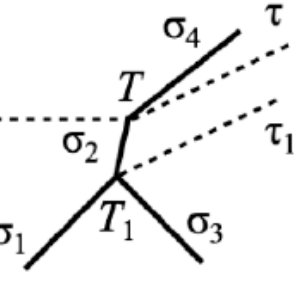
Figure 10. Shock wave configuration for Mach refraction. For irregular refraction, the incident shock σ 1 branches with the formation of a re- flected shock σ 3 and a main shock σ 2 (the Mach stem). The main shock experiences characteristic refraction on the tangential discontinuity τ . The Mach stem is enclosed between two points, T and T 1 , from which tangential discontinuities originate, τ and τ 1 . Figure 11 shows the regions of existence of a shock wave structure with a different type of reflected discontinuity r 3 (Figure 1), which are formed during refraction of the shock σ 1 at the tangential discontinuity τ .